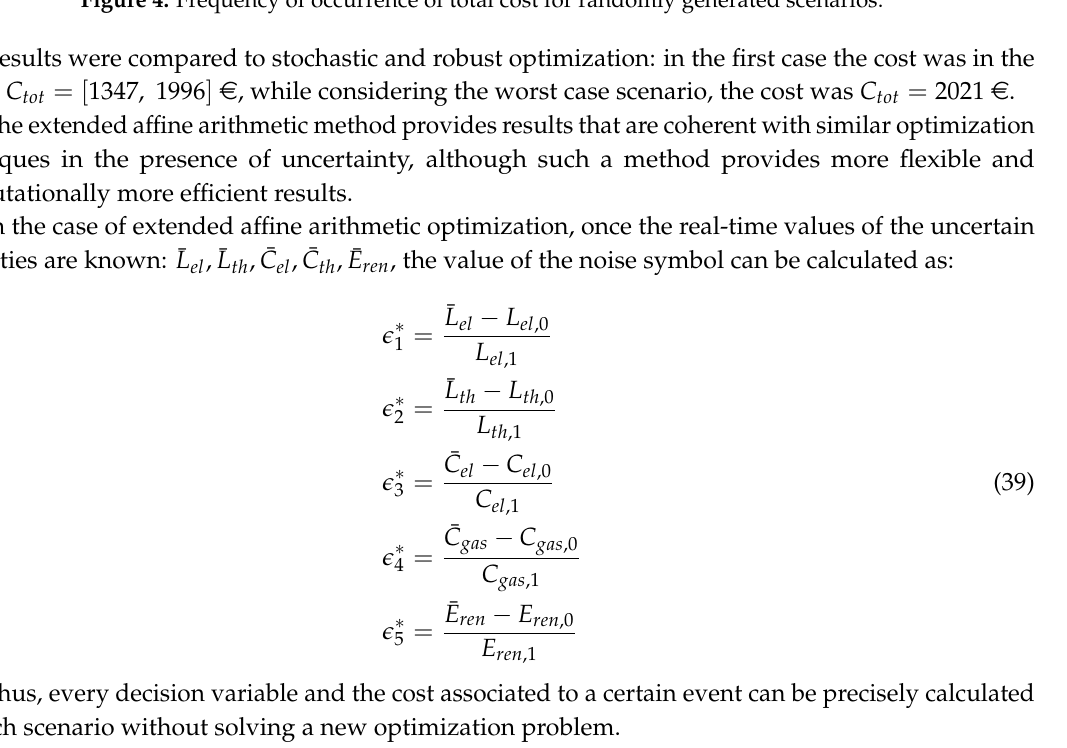
Figure 4. Frequency of occurrence of total cost for randomly generated